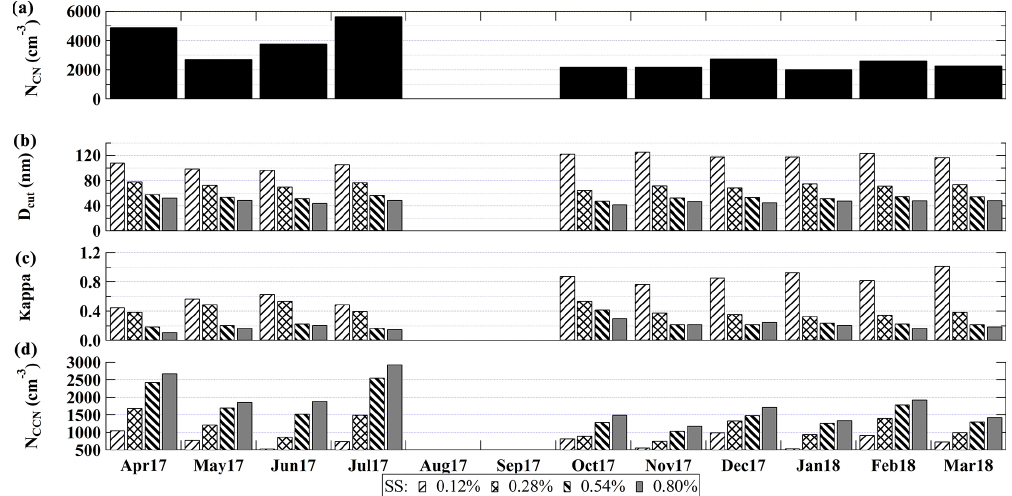
Figure 4. Seasonal variations in the number concentration of total particles ( N CN ) and the number concentration of the cloud condensation nuclei ( N CCN ), kappa value ( κ ) and activation diameter ( D cut ) measured for an SS value of 0.12%, 0.28%, 0.54% and 0.80%.